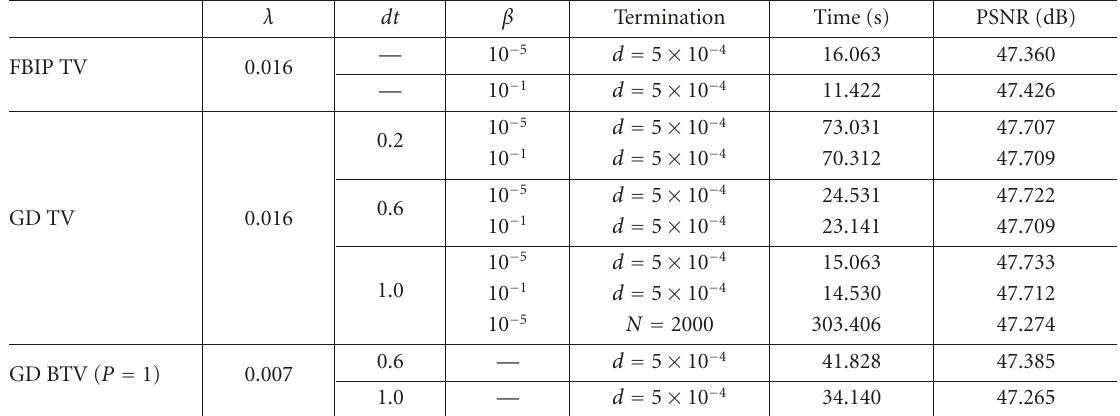
Table 1: Comparison with GD TV and BTV algorithms in the synthetic “noise-free” case (4 frames).